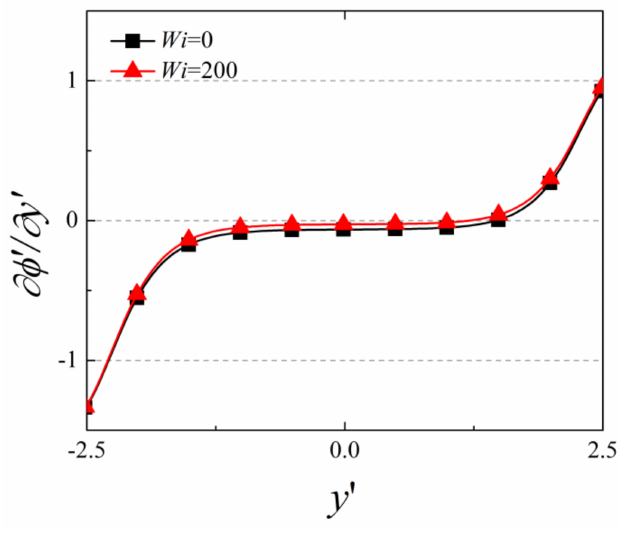
∂ ∅ (cid:48) ∂ y (cid:48) along the symmetry axis of the nanochannel for C 0